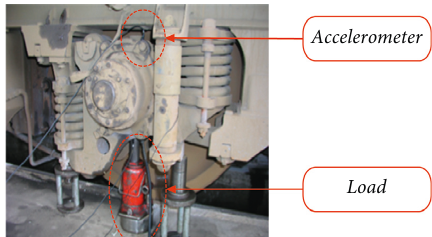
Figure 6: Experimental locomotive bearing device.